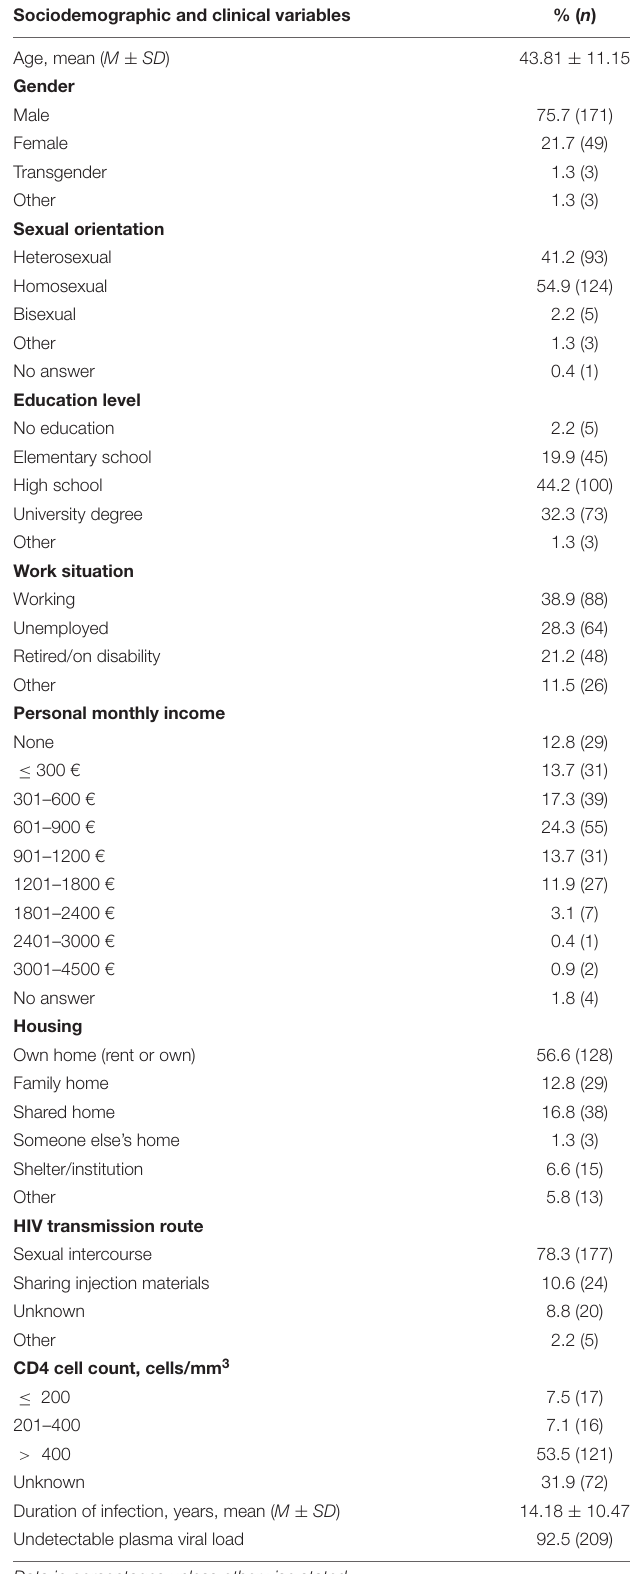
TABLE 2 | Characteristics of pilot study participants ( N = 226). Sociodemographic and clinical